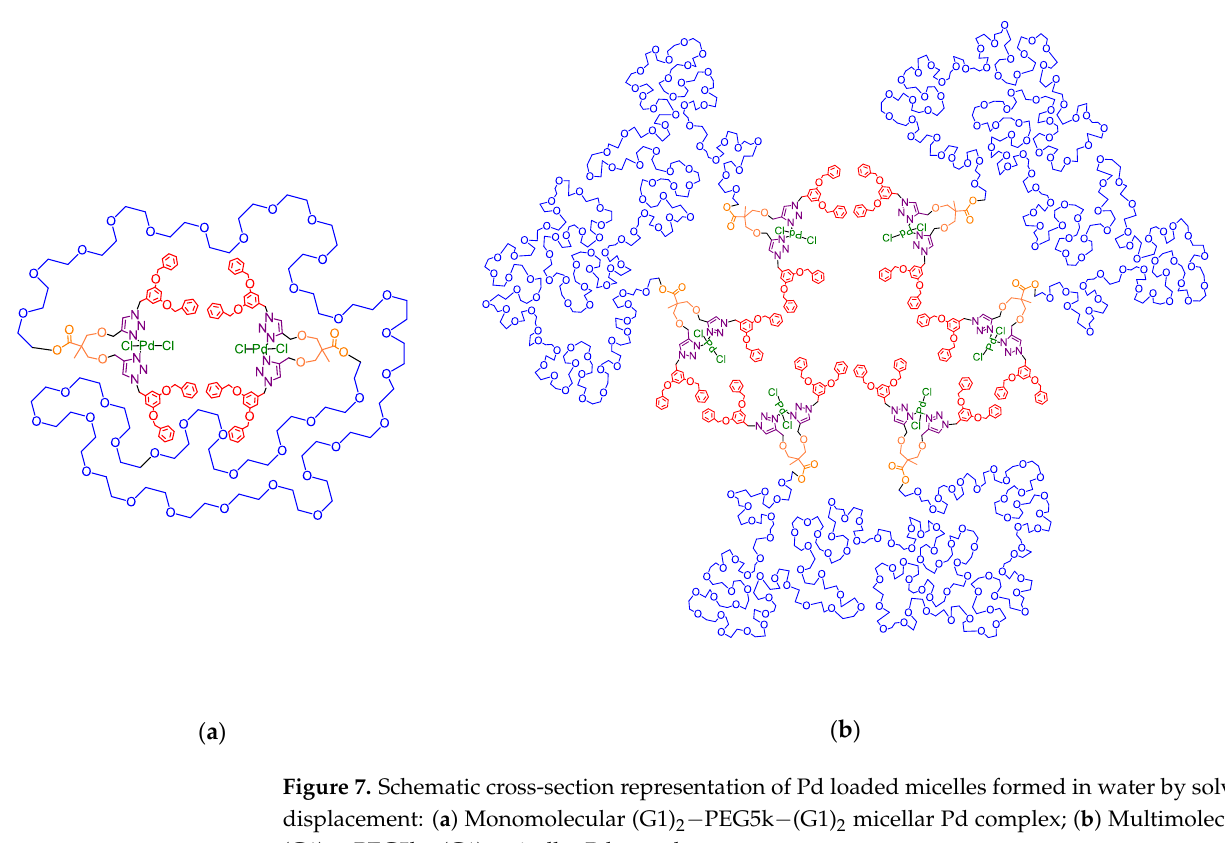
Figure 7. Schematic cross-section representation of Pd loaded micelles formed in water by solvent displacement: ( a ) Monomolecular (G1) 2 − PEG5k − (G1) 2 micellar Pd complex; ( b )